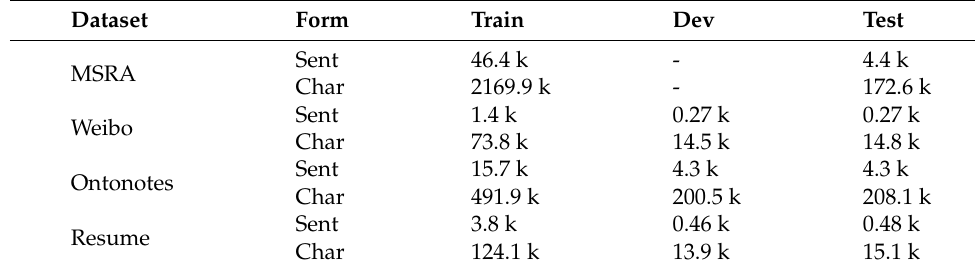
Table 1. The statistics of the